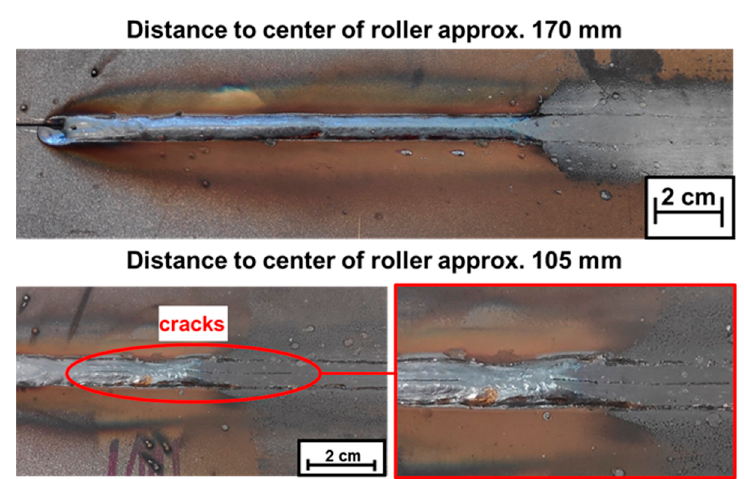
Figure 6. Samples after WeldForming with different distances between torch and roller.